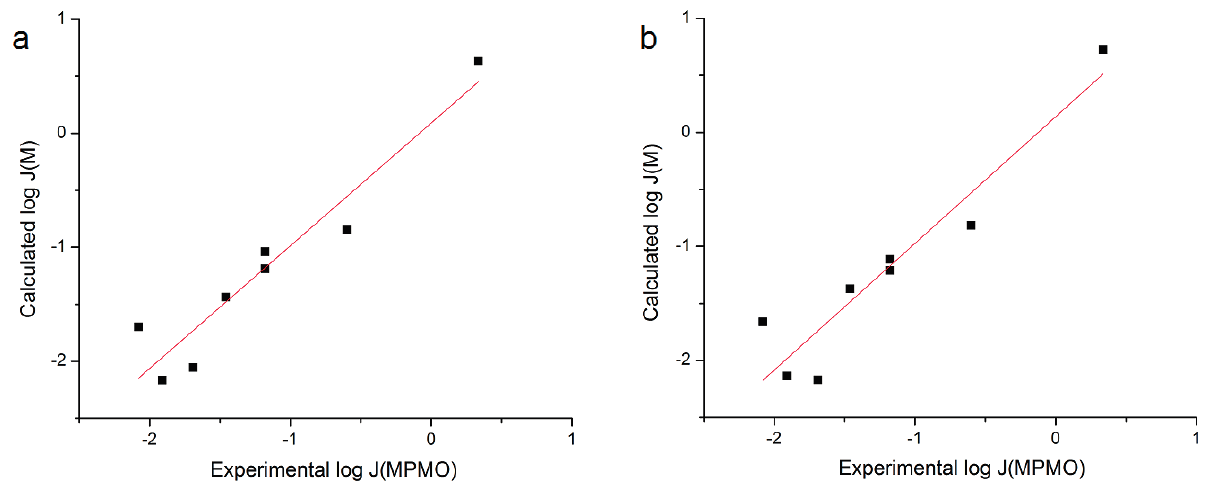
calculated with the coefficients derived from nonlinear regressions M , S MO 1.0